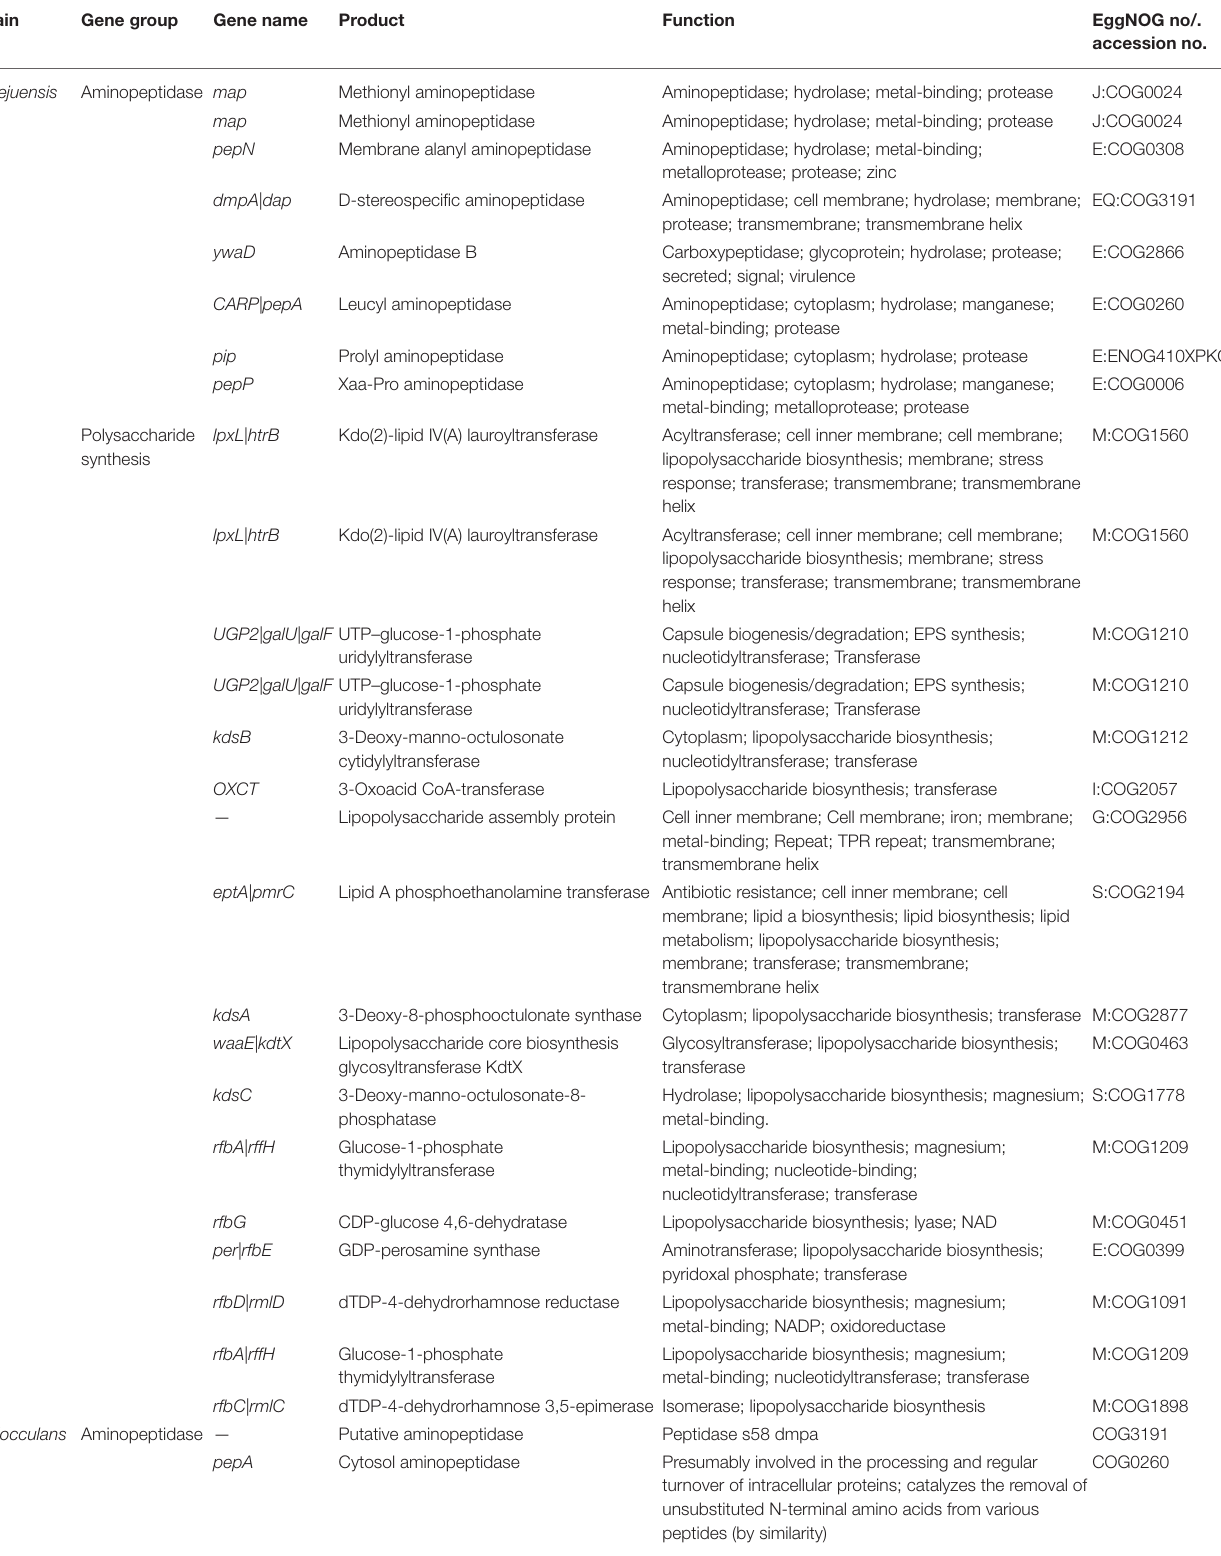
TABLE 2 | List of predicted aminopeptidase and polysaccharide synthesis genes related to flocculation in M. jejuensis, C. flocculans , and E. coli . Strain Gene group EggNOG no/.